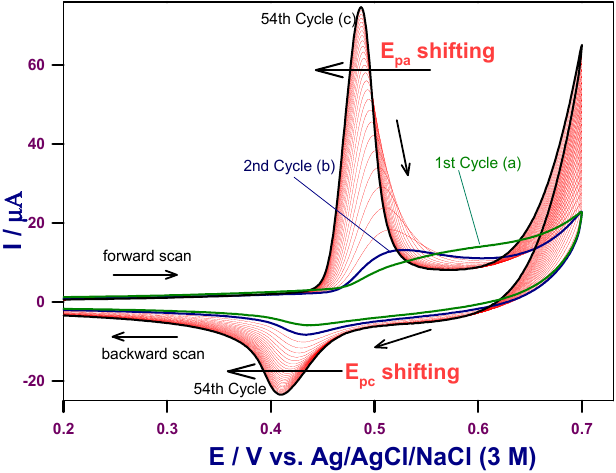
Figure 1. Cyclic voltammograms of the HCNiO/GC electrode (a) first cycle; (b) second cycle; and (c) 54th cycle in the potential between 0.2 V to 0.7 V in 0.05 M NaOH solution, at a scan rate of 0.05 V·s − 1 .